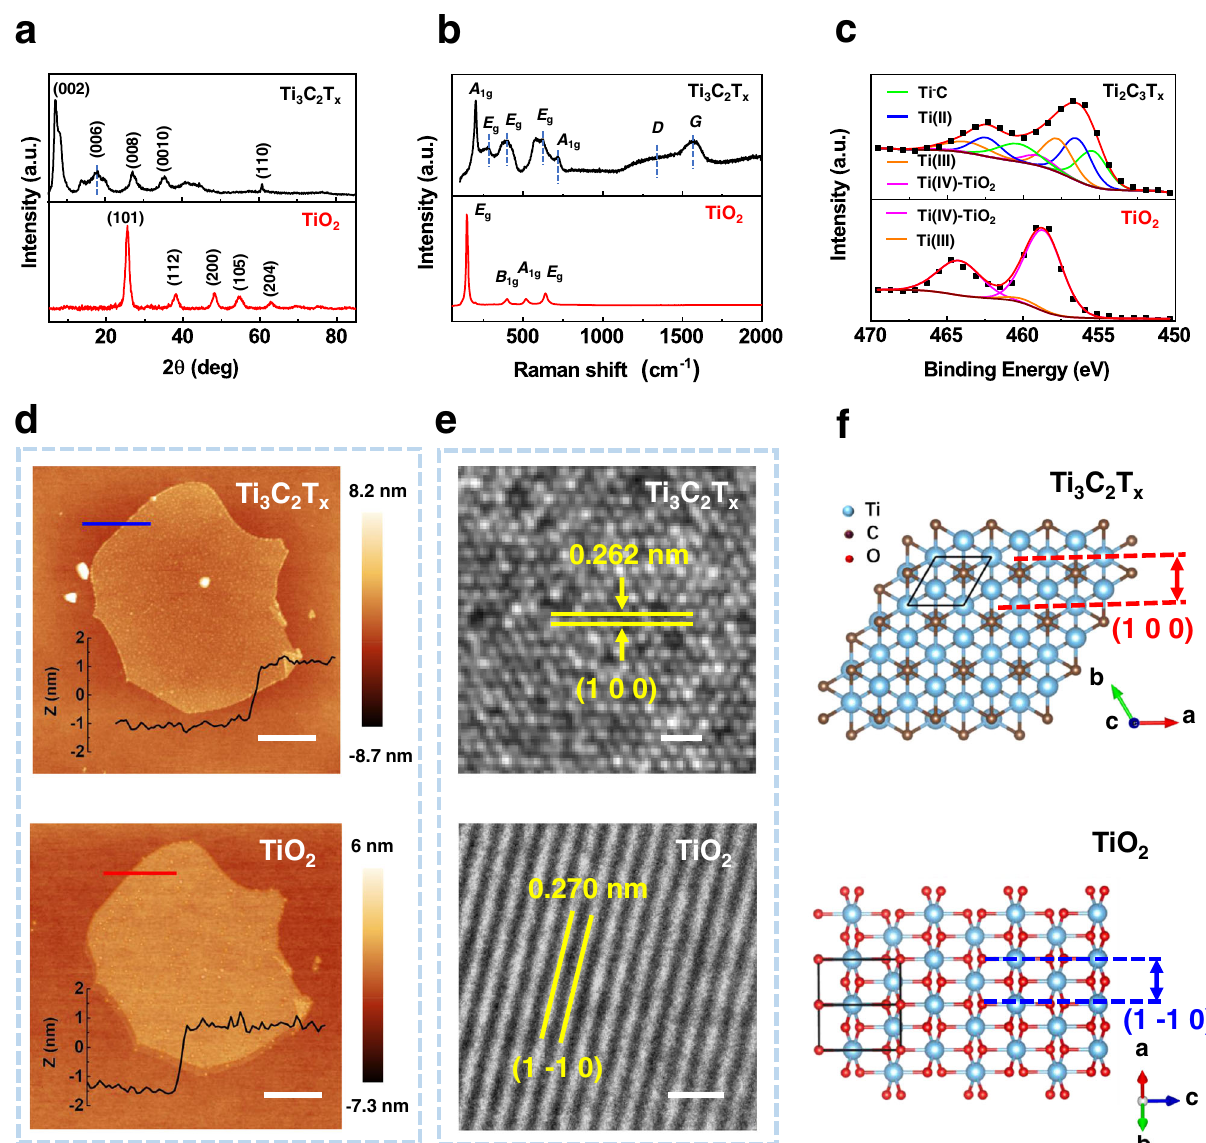
Fig. 2 Conversion of Ti 3 C 2 T x into 2D TiO 2 fl akes. a XRD patterns and b Raman spectra of the Ti 3 C 2 T x before and after annealing at 400 °C for 50 h. c XPS spectra of the Ti 3 C 2 T x and the derived TiO 2 ; d AFM images and height pro fi les of Ti 3 C 2 T x and a derived TiO 2 fl ake on a SiO 2 /Si substrate (scale bar: 2 μ m); e HRTEM images of Ti 3 C 2 T x and derived TiO 2 fl akes (scale bar: 1 nm); f Crystal structures of Ti 3 C 2 T x and derived anatase phase of TiO 2